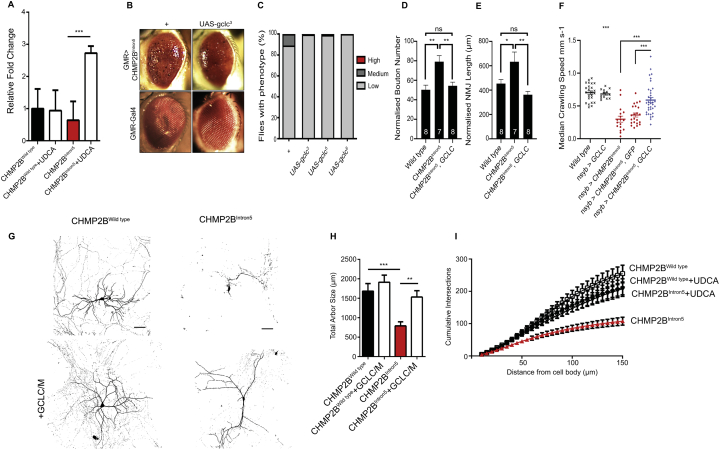
UDCA Identifies GCLC As a Novel Regulator of CHMP2BIntron5 Toxicity.A. The mRNA abundance of gclc from pan-neuronally expressing CHMP2BIntron5 third instar larval brains shows a significant upregulation when raised on UDCA (600 μM) supplemented food compared to vehicle (ethanol). Mean ± SEM, n = 5 per genotype, fold change values in log2 scale. ⁎⁎⁎ q < 0.001.B. Representative images of the Drosophila eye phenotype caused by CHMP2BIntron5 expression with eye-specific GMR-Gal4 driver (GMR-Gal4, UAS-CHMP2BIntron5) and amelioration by co-expression of UAS-GCLC.C. Quantification of the eye phenotype from (B) genotypes. n = 100.D, E. Co-expression of GCLC (UAS-GCLC6) ameliorates unregulated synaptic growth characterised by increased bouton number (D) and NMJ length (E) at the third instar larval NMJ (Muscle 6/7, hemisegment A3) in CHMP2BIntron5 (nSyb-Gal4) expressing larvae. ANOVA with post-hoc Tukey comparison between groups ⁎p < .05, ⁎⁎p < .01.F. Pan-neuronal (nSyb-Gal4) expression of GCLC rescues aberrant crawling behaviour in 3rd instar wandering larvae pan-neuronally expressing CHMP2BIntron5. ANOVA with post-hoc Dunnett's comparison to wild type controls ⁎⁎⁎p < .001 and Tukey comparison between groups ###p < .001.G. Representative micrographs of mature neurons expressing FLAG-tagged CHMP2BWildtype or CHMP2BIntron5 ± plasmids expressing the catalytic (GCLC) and modifying (GCLM) subunits of glutamate cysteine ligase (GCL).H,  I Quantification of total arbour size (H) and cumulative number of intersections per unit distance (I) in CHMP2BWildtype or CHMP2BIntron5 ± GCLC/M. Data represents mean ± SEM analysed using one-way ANOVA and Tukey's multiple comparisons post hoc test (##p < .01, ###p < .001). Scale bar = 50 μm. 20 neurons analysed, per condition, across 3 biological replicates.